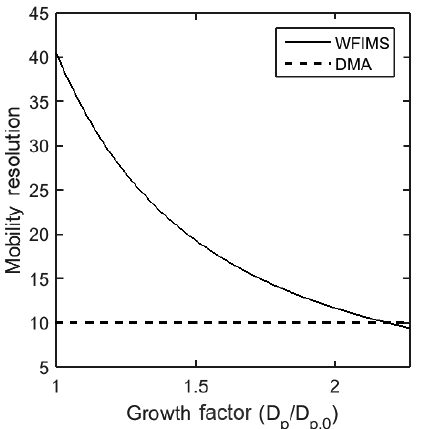
Figure 7. WFIMS mobility resolution (solid line) and typical DMA mobility resolution (dashed line) as a function of growth factor ( D p /D p , 0 ) for nondiffusing particles with 50nm dry